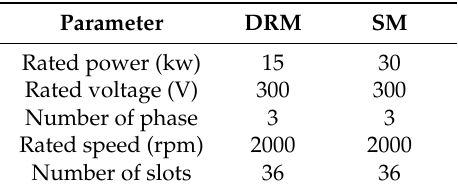
Table 4. The simulation parameters of DRM and SM.